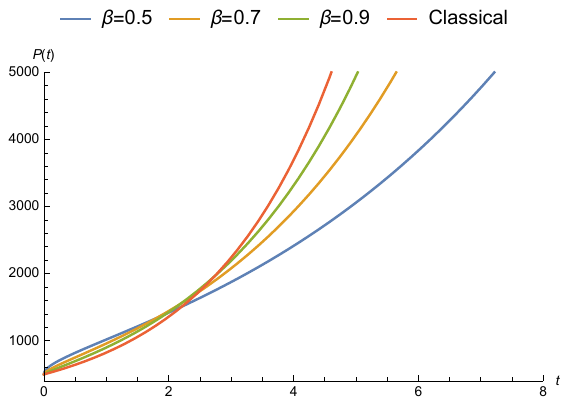
Figure 6. Analysis of the Malthusian growth model under different orders while α =